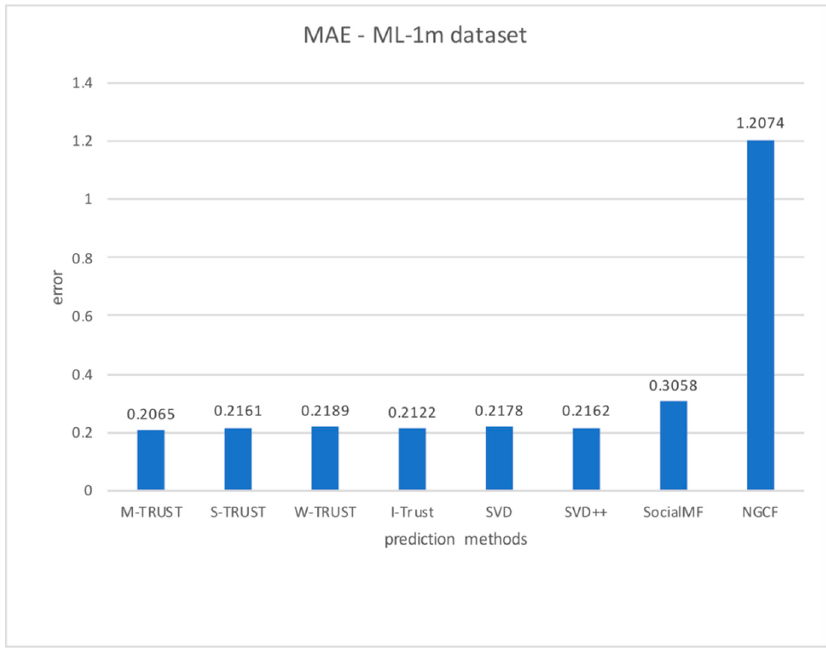
Figure 4. Prediction accuracy for the ML-1m data set, obtained using different comparison methods.